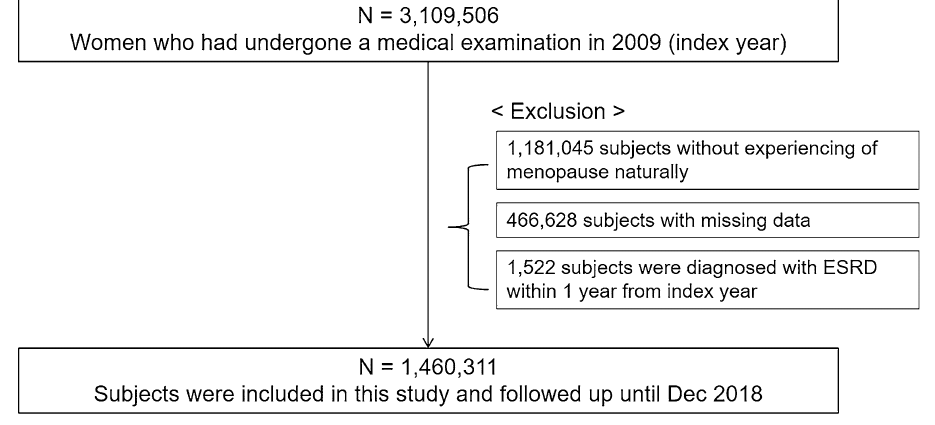
Figure 2. The schematic flow chart of the study